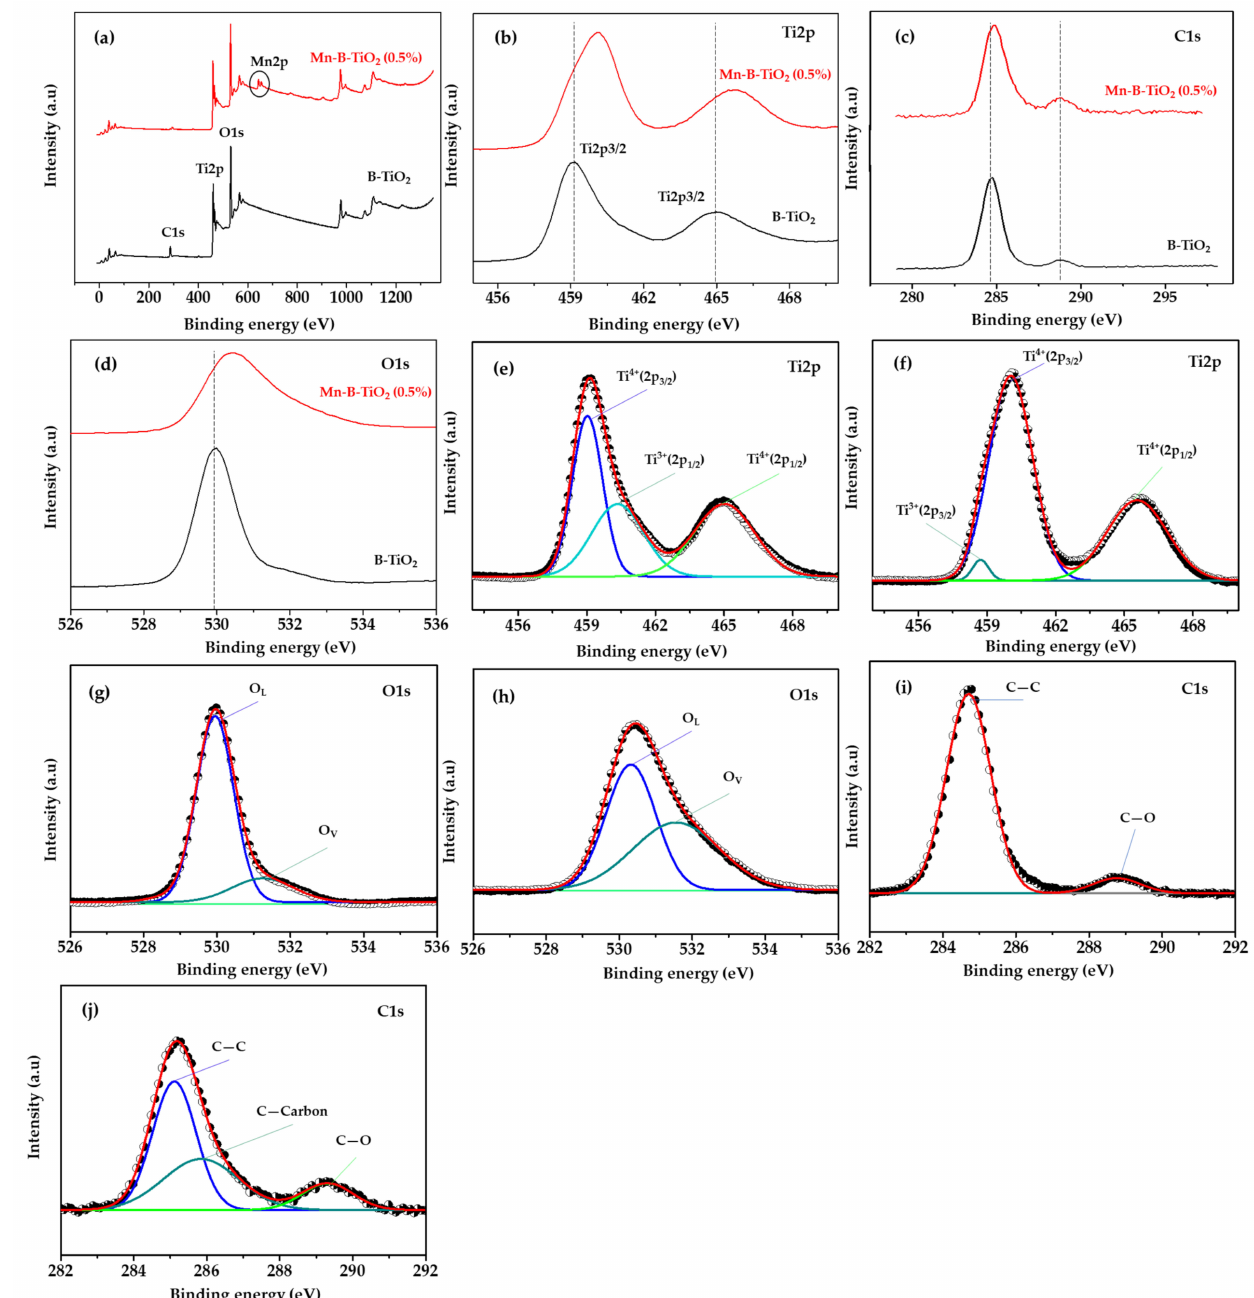
Figure 5. Comparison of ( a ) XPS survey spectra, ( b ) Ti2p spectra, ( c ) C1s spectra, and ( d ) O1s spectra; and deconvoluted Ti2p spectra of ( e ) B-TiO 2 ( f ) Mn-B-TiO 2 ; deconvoluted O1s spectra of ( g ) B-TiO 2 ( h ) Mn-B-TiO 2 ; deconvoluted C1s spectra of ( i ) B-TiO 2 ( j ) Mn-B-TiO 2